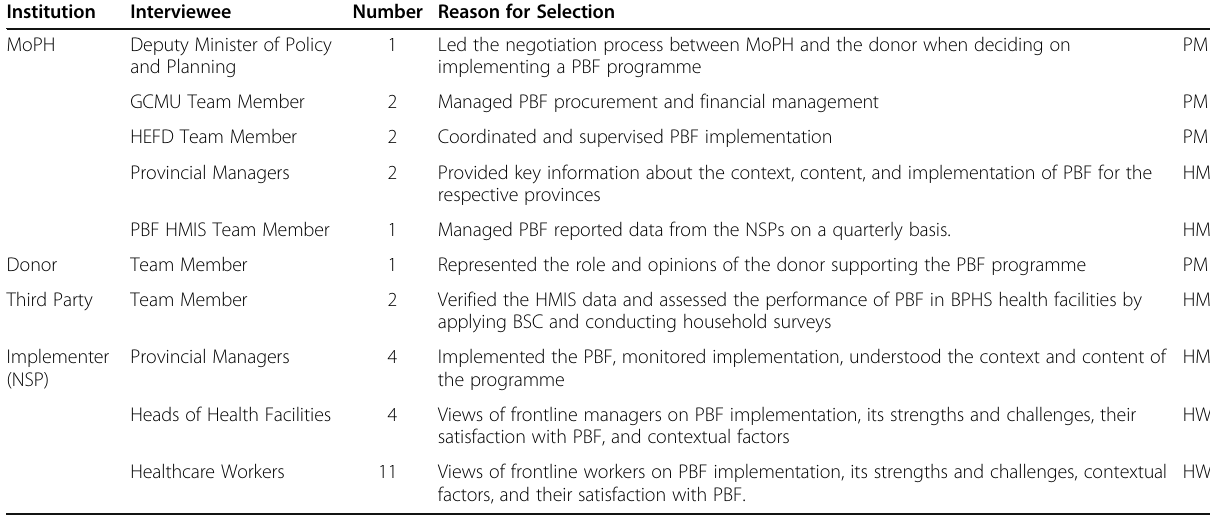
Table 1 Research participants